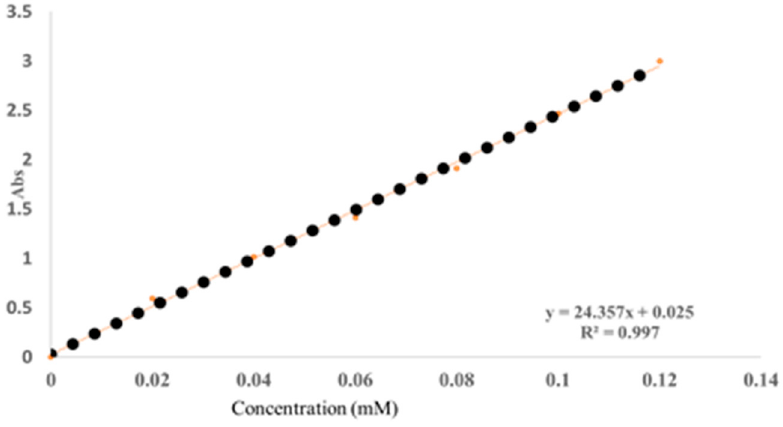
Figure 3. Calibration curve of 4-NP at different concentrations.